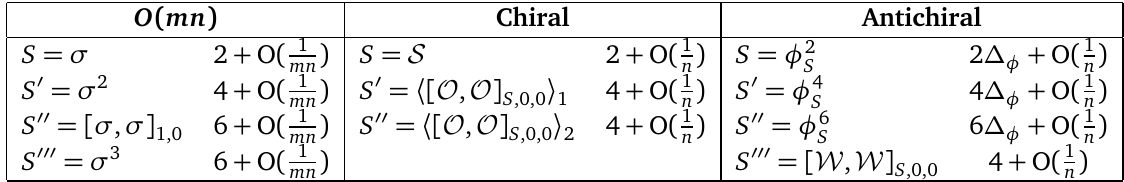
Table 1: The lowest scalar singlet operators at the three non-trivial fixed points and their scaling dimensions. In the chiral fixed point, the operators S (cid:48) and S (cid:48)(cid:48) arise from resolving a mixing, where O is either S or W . O ( mn ) Chiral